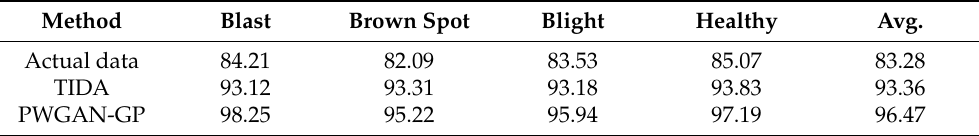
Table 12. Impact of data enhancement on the accuracy of the ResNet-50 model (%).